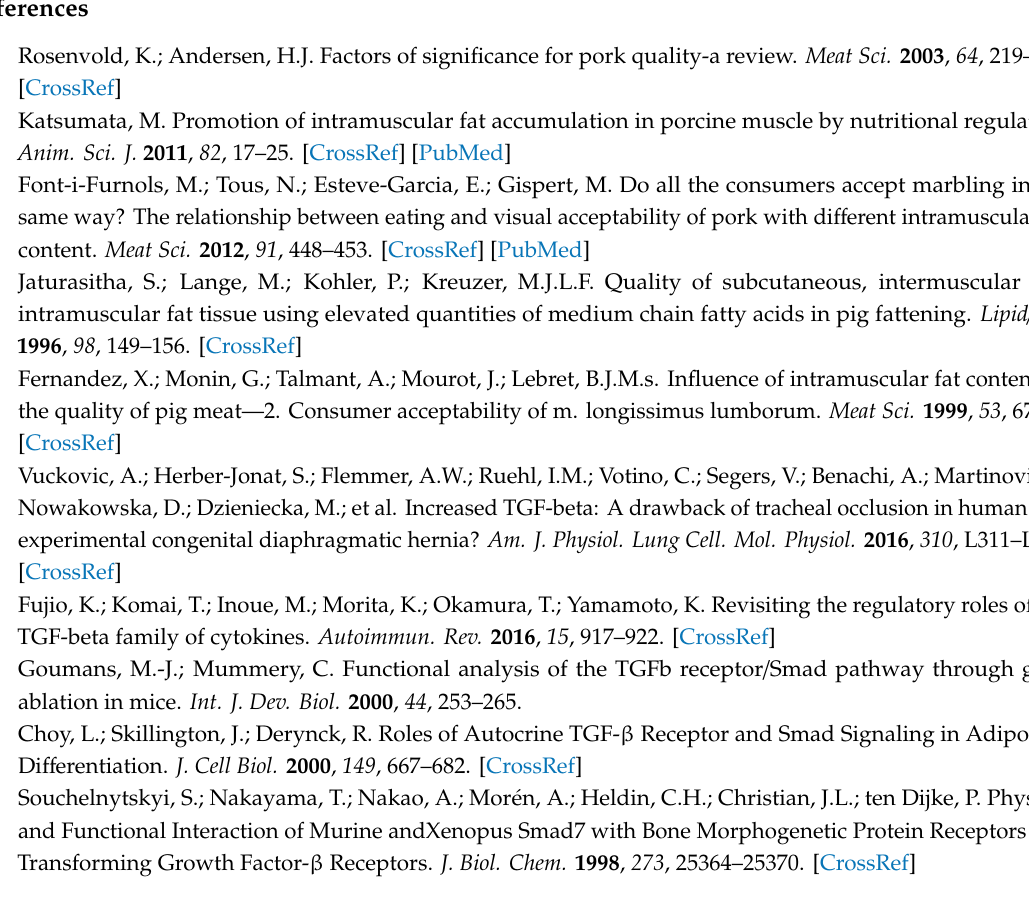
Table S1. Primers used for RT-qPCR; Table S2. Di ff erentially expressed lncRNAs; Table S3. Di ff erentially expressed genes. Figure S1. The most enriched GO (Gene Ontology) terms of DEGs (Di ff erentially Expressed Genes). Figure S2. The miRNA that FDNCR1